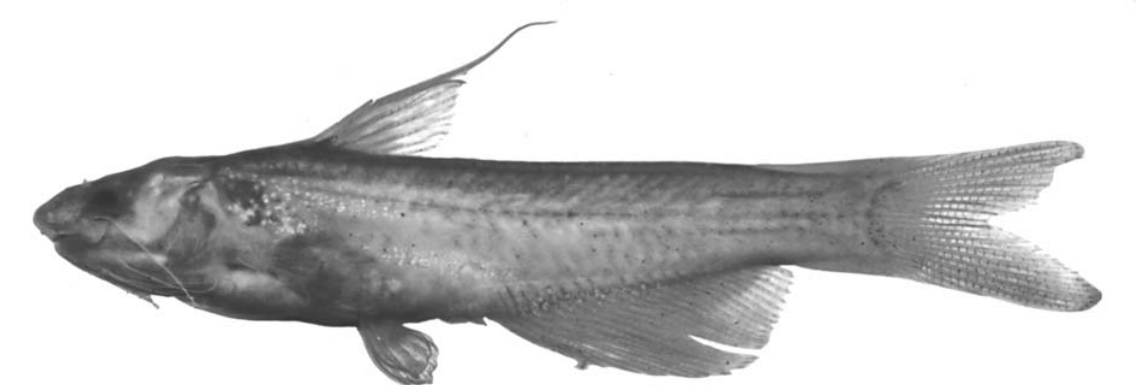
Fig. 8. Cetopsidium pemon , new species, holotype, mature male, MCNG 19475, 25 mm SL; Venezuela, Bolivar, río Caroni at